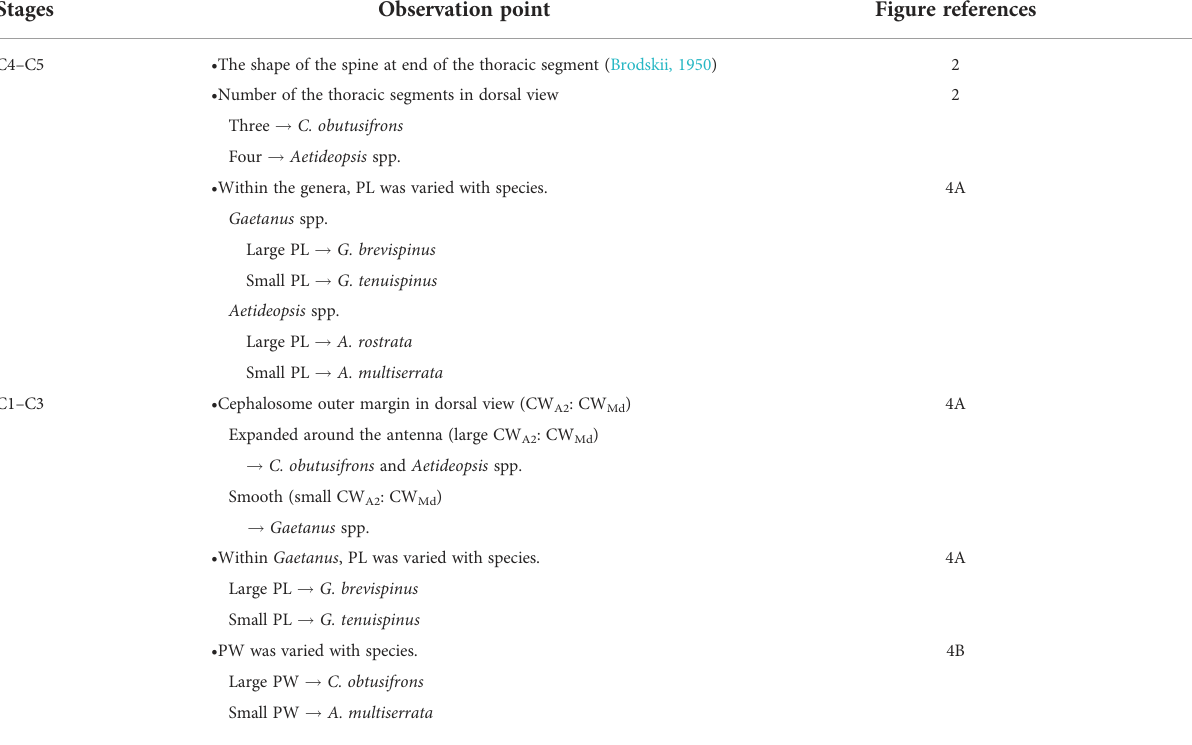
Stages Observation